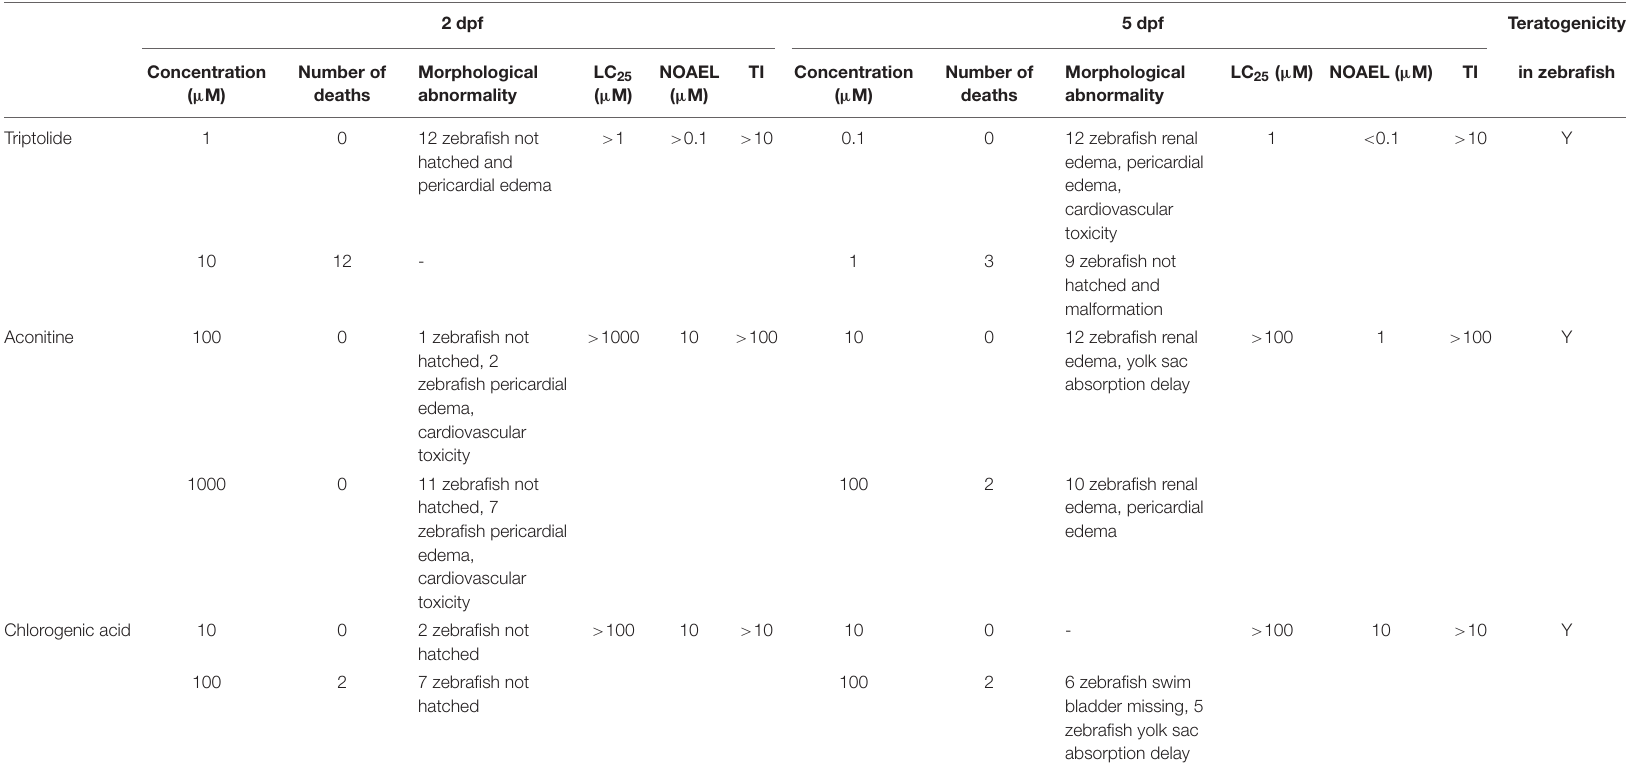
TABLE 6 | Application of the Optimized Zebrafish Developmental Toxicity Assay for triptolide, aconitine, and chlorogenic acid. 2